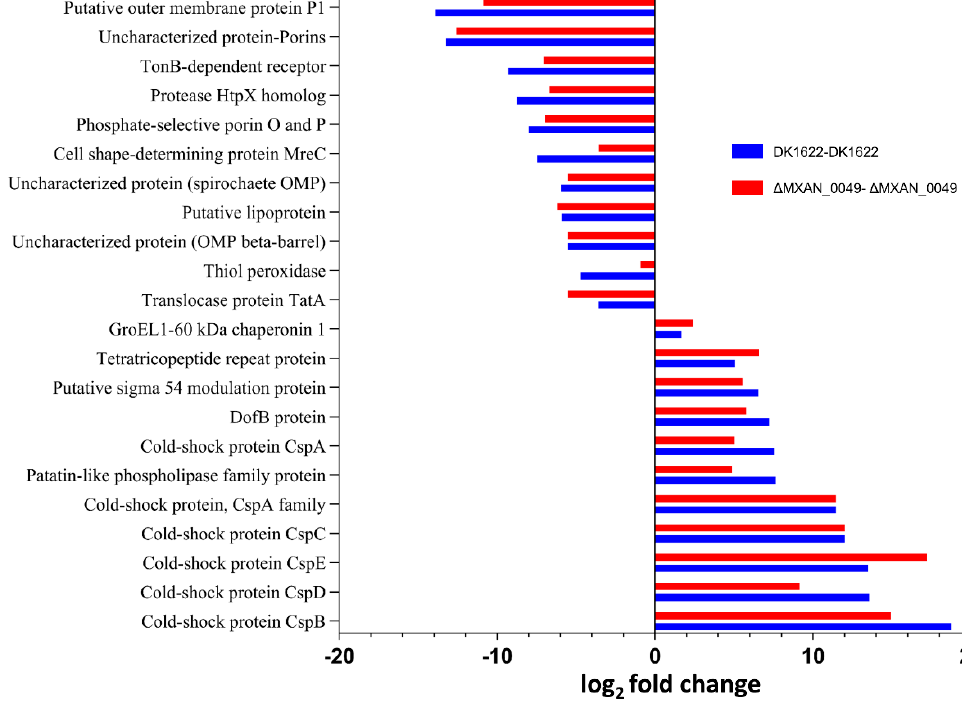
Figure 3. Different up- and down-regulated proteins when the boundary formed compared to the non-boundary samples based on coverage value. Cold shock proteins (Csps) were more than 10-fold up-regulated compared to both control samples. Other proteins such as patatin-like phosphate, Dof-B protein (DofB), tetratricopeptide repeat (TPR) and chaperonin GroEL1 were also significantly up-regulated in the boundary. Porins, putative outer membrane proteins P1, and TonB-dependent receptor were down-regulated significantly in the case of the boundary when compared with both control samples, DK1622-DK1622 and Δ MXAN_0049 – Δ MXAN_0049 .